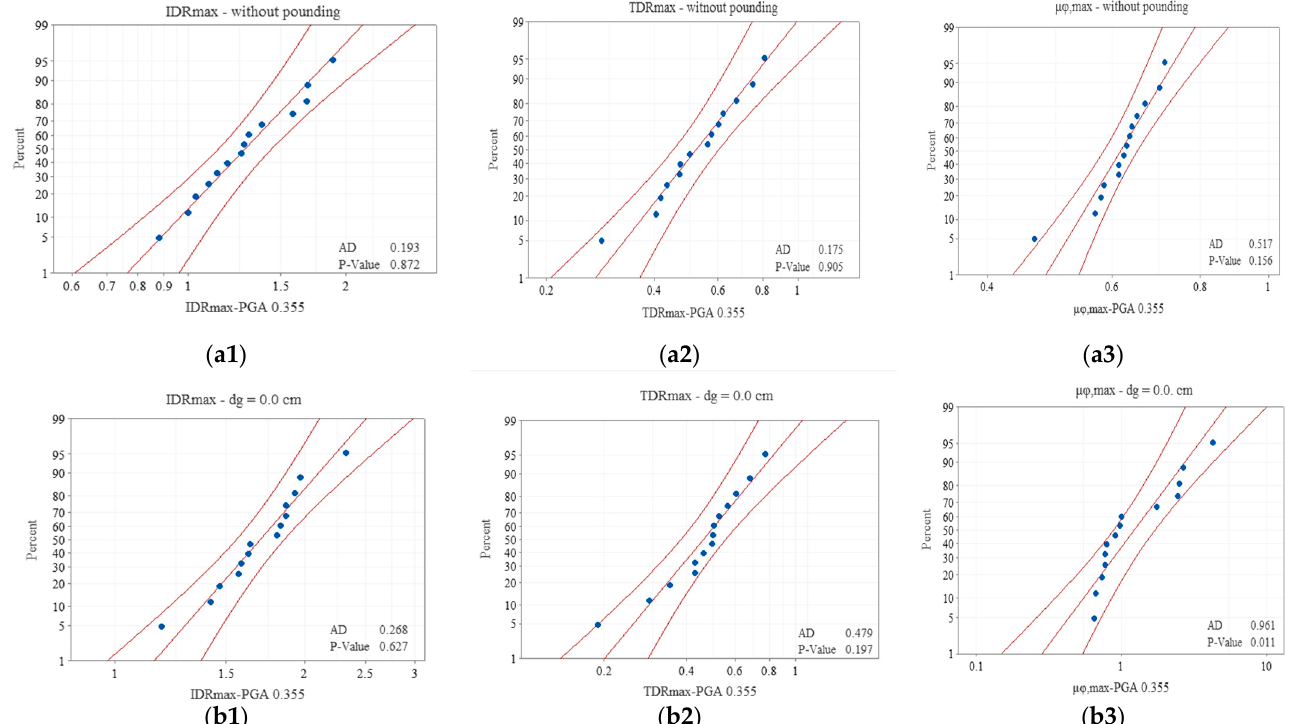
Figure 8. Lognormality assumption: Probability plot at PGA = 0.355 g in the case of ( a ) without the pounding effect, and ( b ) when d g = 0.0 cm. Examined engineering demand parameters: ( 1 ) IDR max , ( 2 ) TDR max , and ( 3 ) μ φ ,max . Table 3. Check of the lognormality assumption (p-value cut off equal to 0.05).